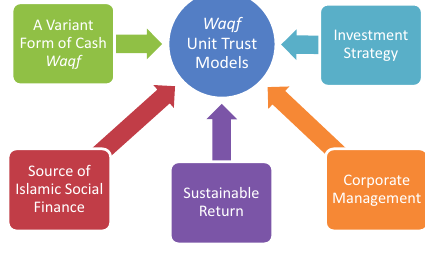
Figure 1. Conceptual framework of